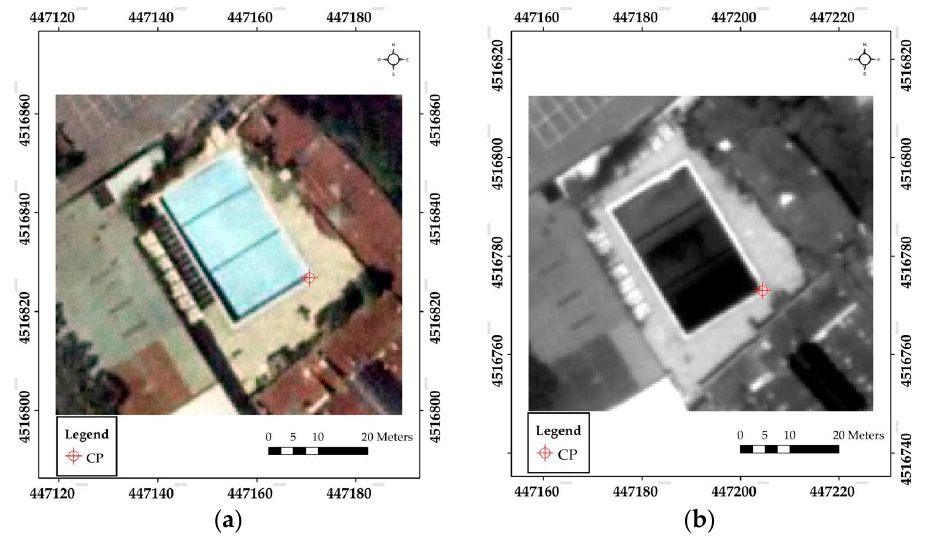
Figure 2. Check point (CP) identification: ( a ) CP in orthophoto; ( b ) corresponding CP in the WV-2 primary panchromatic image. The coordinates reported are referred to as UTM/WGS84 (33 N—zone T) and are expressed in meters.